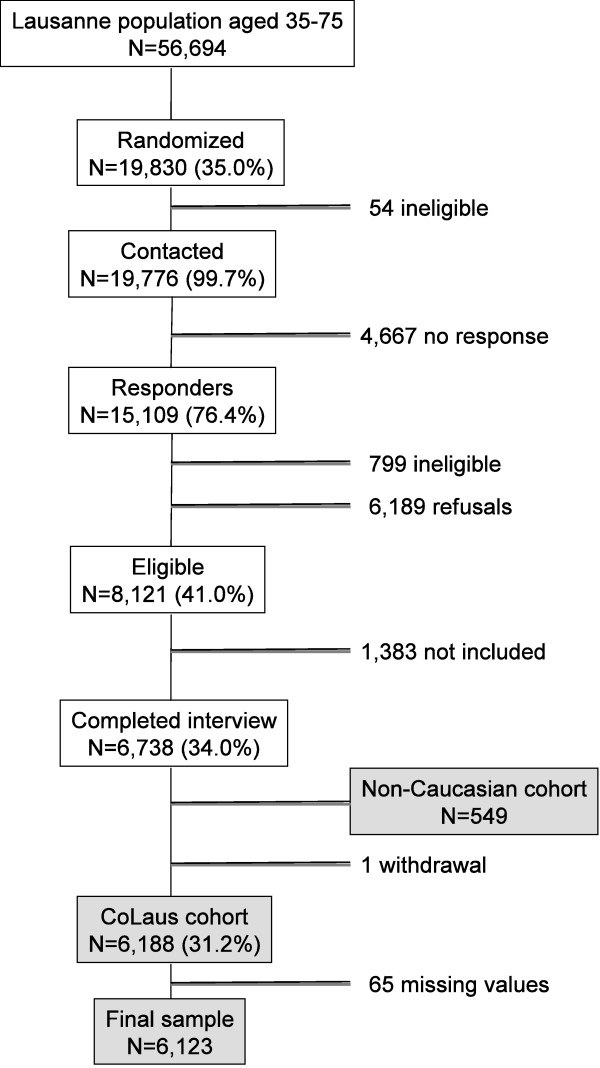
Sampling procedure.